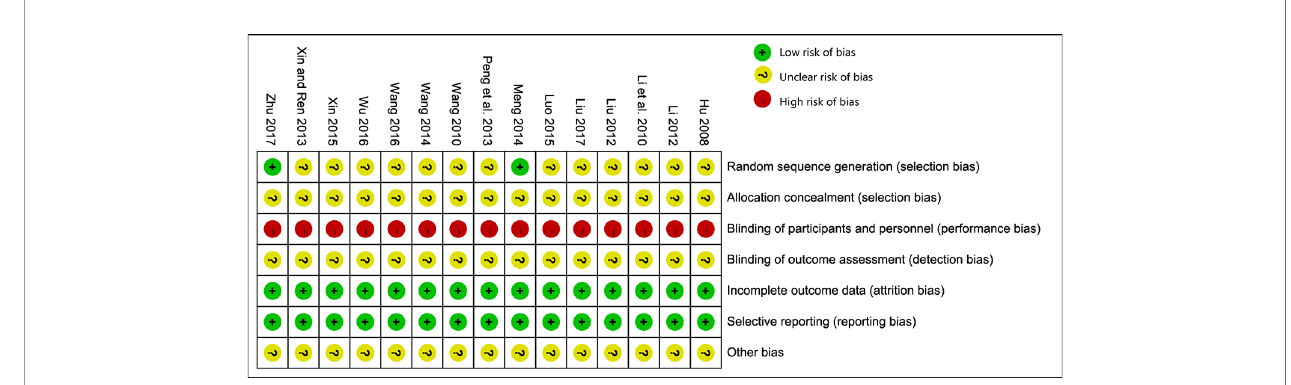
FIGURE 2 | Risk of bias summary.